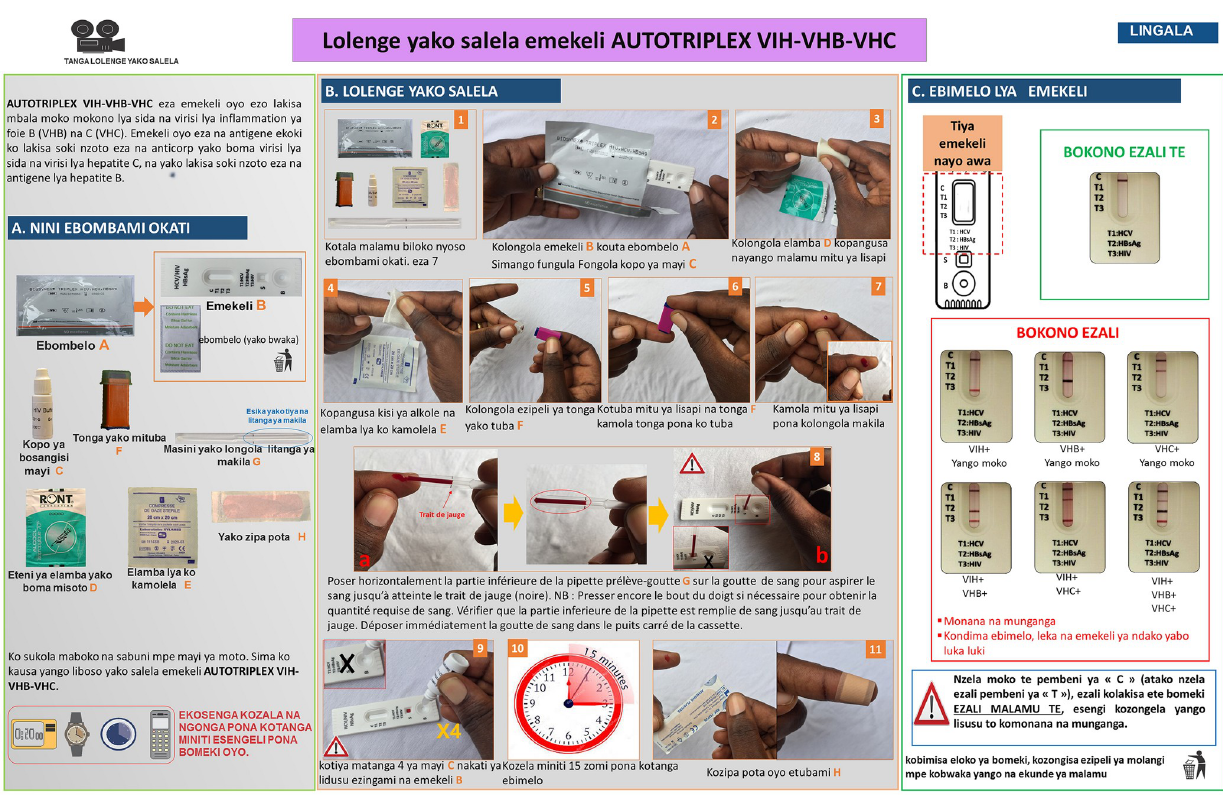
Fig 1. Instructions for use of the Triplex HIV/HCV/HBsAg self-test designed for the Congolese general public using typical pictures representative of the principal steps of the manufacturer’s instructions with explanations written in Lingala, which is one of the most frequently used vernacular languages of the former Province Orientale of the Democratic Republic of the Congo. Other available languages were French and Swahili. A . Identification of the components : Ⓐ Pouch, Ⓑ Test cassette, Ⓒ Diluent vial, Ⓓ Alcohol wipe, Ⓔ Compress, Ⓕ Lancet, Ⓖ Pipette, Ⓗ Dressing. B . Performing the Triplex self-test : 1. Check the contents of the kit consisting of seven components; 2. Take the self-test Ⓑ out of the bag Ⓐ and open the diluent vial Ⓒ ; 3. Disinfect the chosen fingertip with the alcohol wipe Ⓓ ; 4. Wipe off residual alcohol with the compress Ⓔ ; 5. Remove the cap of the lancet Ⓕ ; 6. Apply the lancet Ⓕ on the chosen fingertip and push the other tip to sting; 7. Press gently on the fingertip to obtain a large drop of blood; 8. Place the lower part of the pipette Ⓖ horizontally over the blood drop to aspirate the blood until the mark (black) is reached. Note: Press the fingertip again if necessary, to obtain the required amount of blood. Check that the lower part of the pipette is filled with blood up to the mark. Immediately place the drop of BLOOD into the SQUARE well of the cassette Ⓑ . 9. Shed four drops of diluent in the ROUND well DILUENT of the test cassette Ⓑ ; 10. Wait exactly 15 minutes before reading the result; 11. Apply the dressing Ⓗ